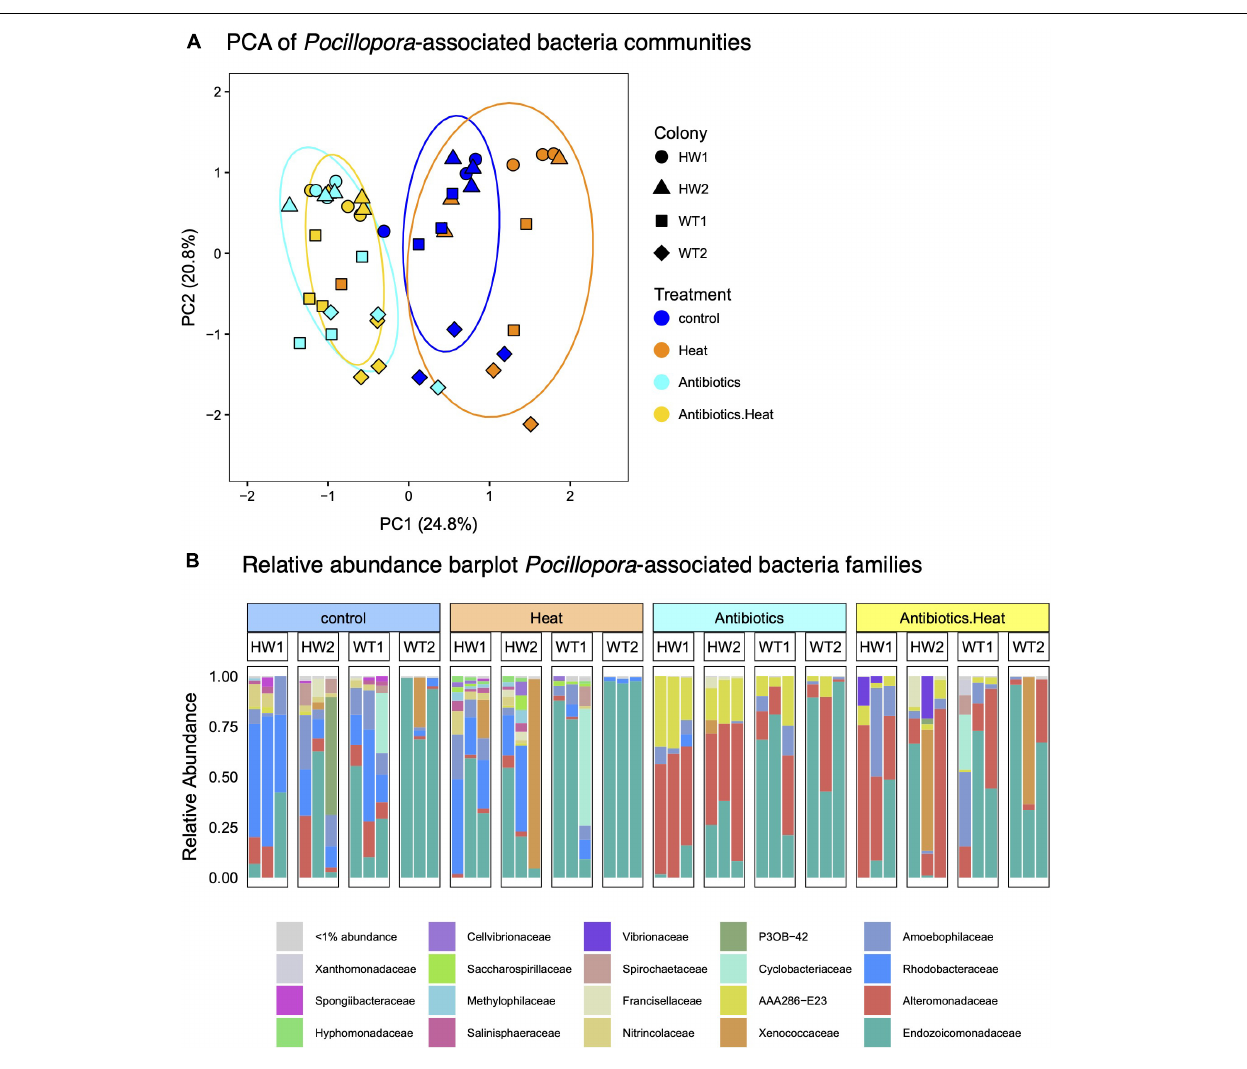
FIGURE 5 | Bacteria 16S sequencing demonstrates that antibiotics treatments alter coral-associated bacteria communities, and that certain coral-associated bacteria families exhibit differential susceptibility to antibiotics treatment. (A) Principal components analysis (PCA) plot of coral-associated bacteria communities reveals that antibiotics-treated samples (yellow and cyan) cluster separately from heat stress and control treatment samples (blue and orange). Point shape represents the sample colony (genotype) and color represents the treatment, with blue for the control treatment, orange for the heat treatment, cyan for the antibiotics treatment, and yellow for the combined treatment. Colored ellipses represent the 95% confidence interval. (B) Barplot of the relative abundance of bacteria families in each treatment reveals significant declines in the abundance of coral-associated Rhodobacteraceae bacteria (royal blue) and increases in Alteromonadaceae bacteria (red) in antibiotics-treated corals, while Endozoicomonadaceae bacteria (dark green) tend to dominate both WT genotypes and are not eliminated by antibiotics